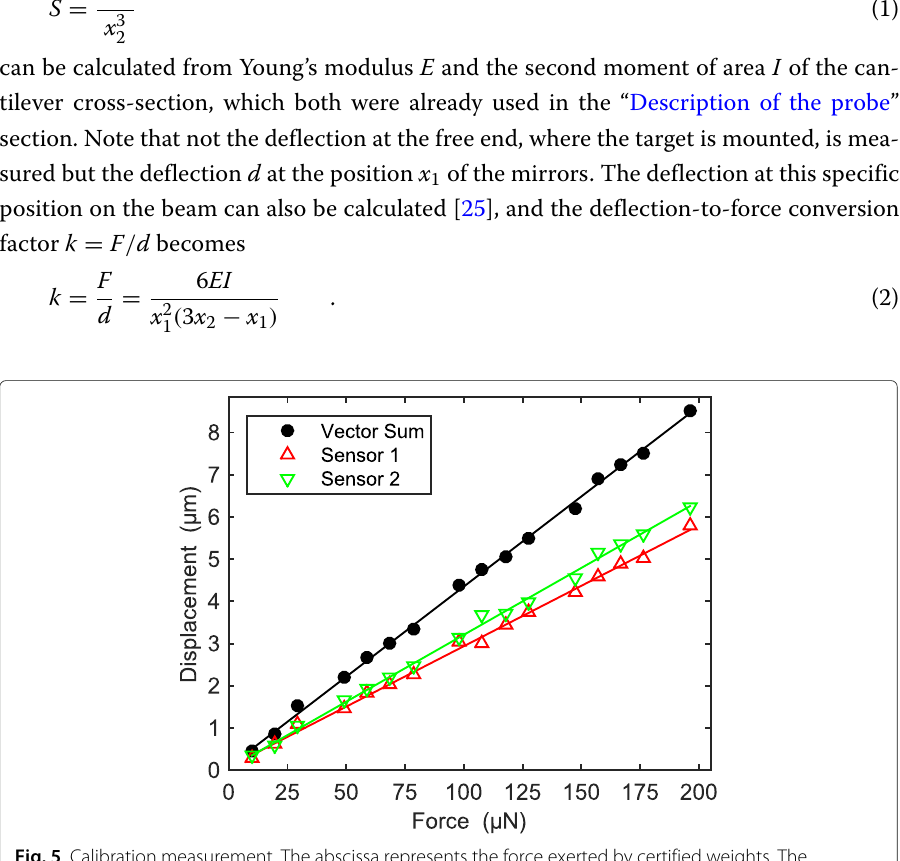
Fig. 5 Calibration measurement. The abscissa represents the force exerted by certified weights. The displacements d 1 and d 2 of the two sensor axes are plotted as well as the magnitude of their calculated (cid:4) (cid:4) (cid:4) (cid:4) + (cid:2) d (cid:4) . The slope of the regression line for the vector sums yields the calibration (cid:4) (cid:2) d vector sums d = 1 2 constant k = 23.4Nm − 1 . Note the different slopes of the lines for two sensors, which result from a small rotation of the calibration setup about the cantilever axis; this small misalignment has no effect on the vector sum, the (calculated) misalignment angle is approximately 3